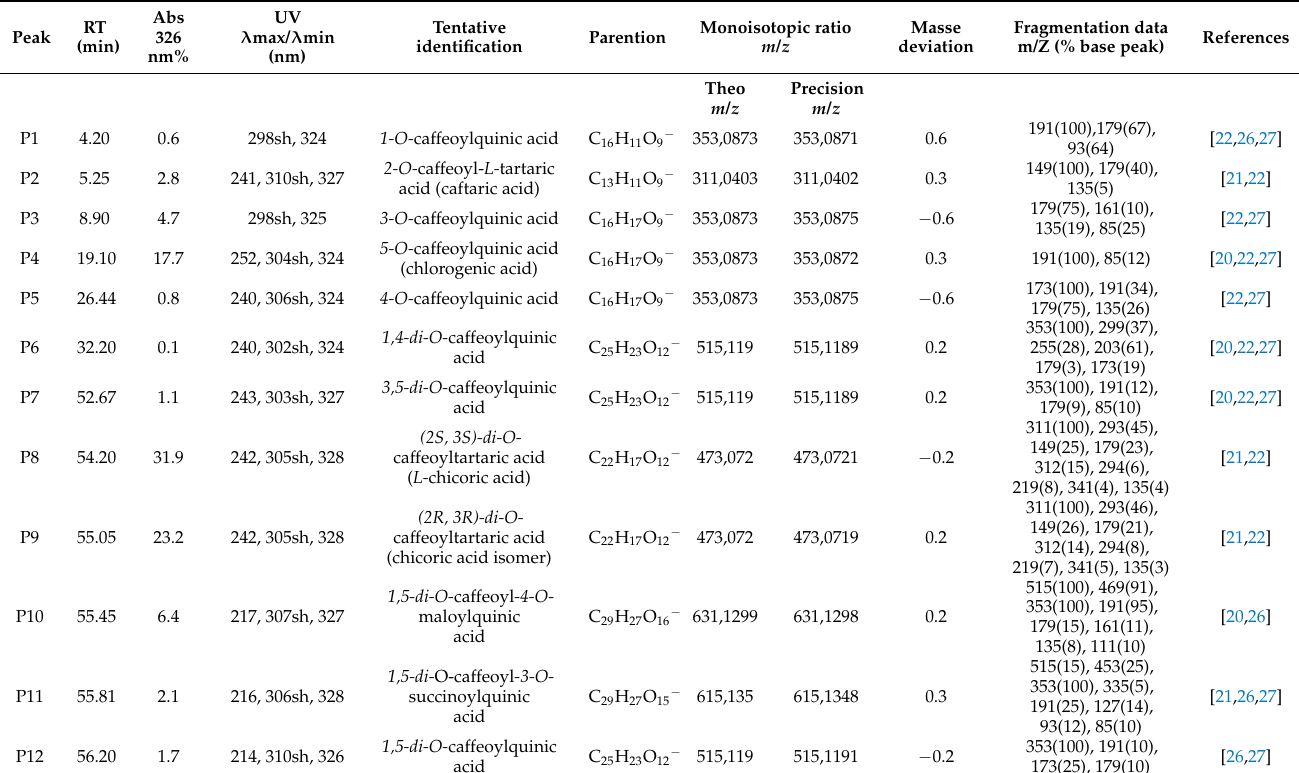
Table 1. UV spectra and characteristic ions of phenolic compounds found in the infusion mixture of dandelion leaves ( Taraxacum officinale WEB. Ex WIGG) and burdock taproot ( Arctium lappa